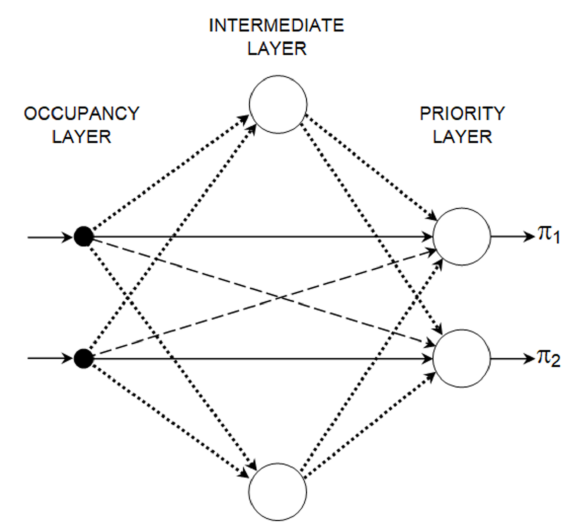
Figure 4. Topology example of FCNN in priority evaluation